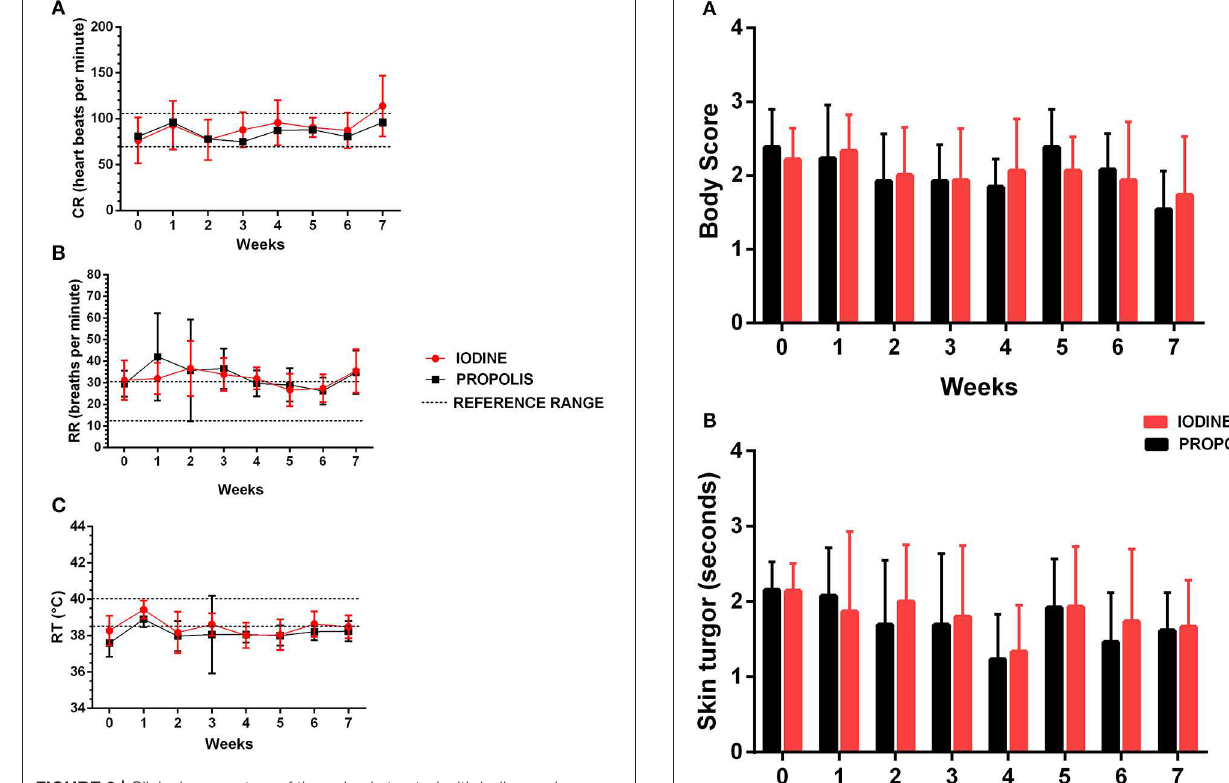
FIGURE 3 | Clinical parameters of the animals treated with iodine and green propolis ointment after excision of the caseous lymphadenitis lesion. The parameters evaluated were (A) cardiac rate, (B) respiratory rate, and (C) rectal temperature. The data are presented as mean, and bars indicate their respective standard deviations. The dashed lines correspond to the reference range ( 2, 24). There were no statistically significant differences between the two experimental groups at any time in any of the parameters, by the Student t -test ( p < 0.05).